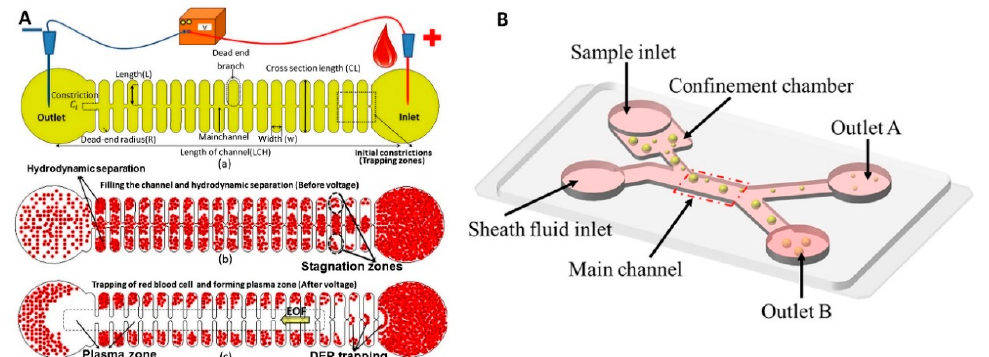
Figure 2. DEP devices with external electrodes. ( A ) Schematic of iDEP chips achieving plasma separation without diluting the blood samples. Reproduced with permission from [54], © 2015 Springer Nature. ( B ) Schematic of chip used for heterogeneous emulsion droplets separation. Reproduced with permission from [56], © 2017 Elsevier.